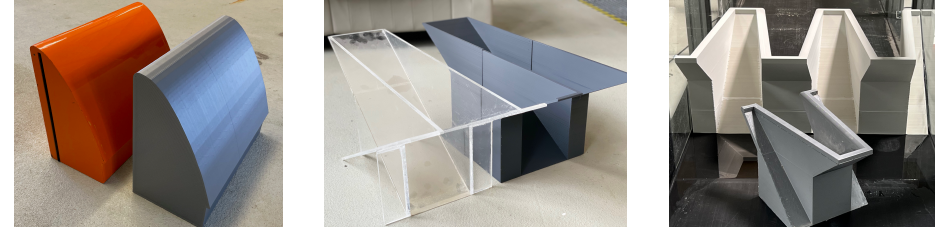
Figure 2. Investigated weir geometries, left : regular linear weirs, middle : rectangular piano key weirs, right : trapezoidal piano key